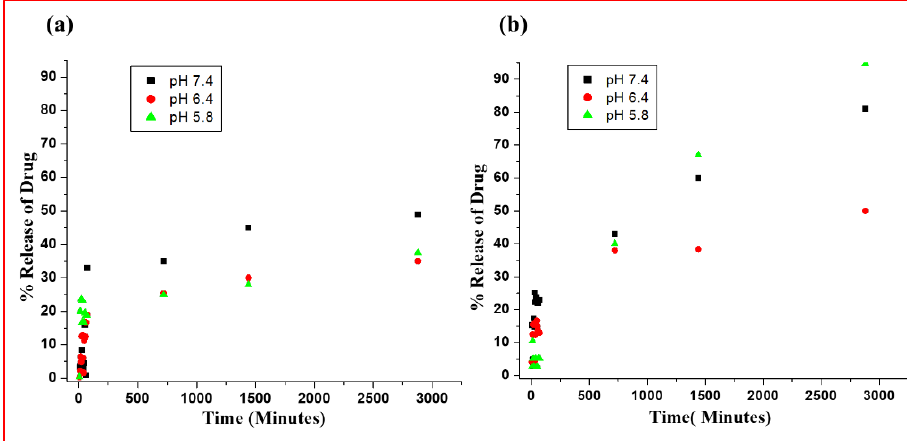
Figure 15. pH response of ( a ) GO-NCD- 1 and ( b ) GO-NCD- 2 .